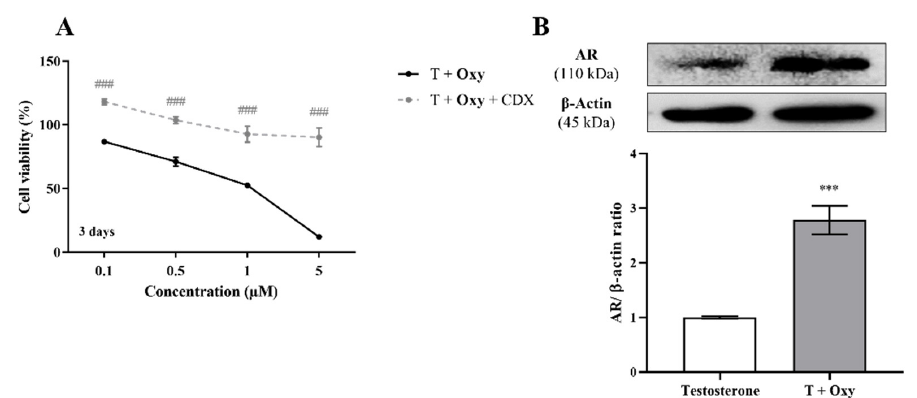
Figure 8. Involvement of AR in the effects induced by Oxy on breast cancer cells. ( A ) Effects of Oxy (0.1–5 µ M) on viability of MCF-7aro cells stimulated with T (1 nM) and treated with or without CDX (1 μ M) after 3 days. ( B ) Effects of Oxy (1 μ M) on the expression levels of AR protein after